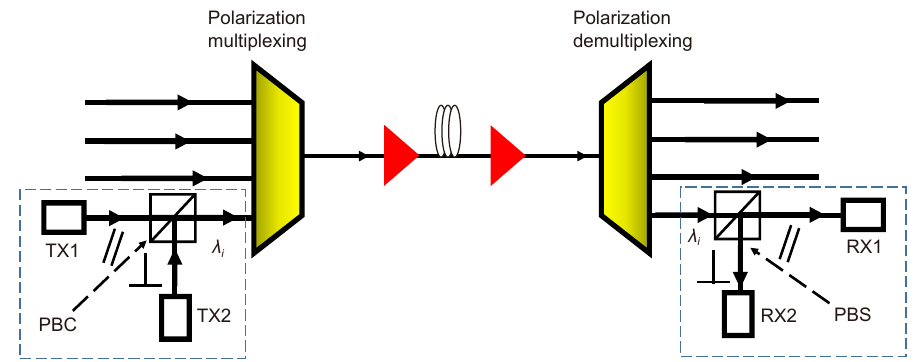
Fig. 5 | Schematic representation of the PDM